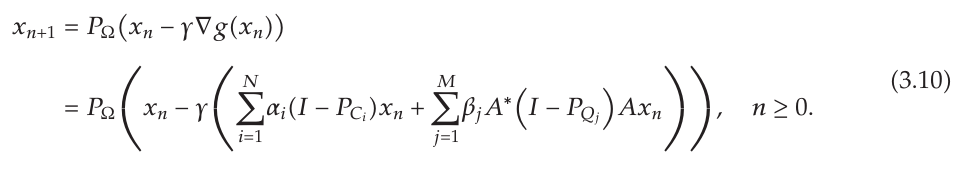
Algorithm 3.9. Gradient-projection